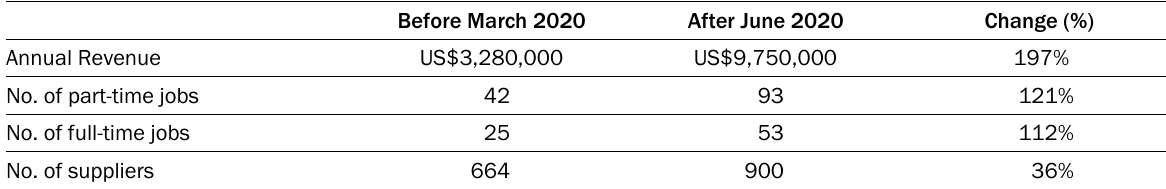
Table 2. Key Performance Indicators (KPI) of the 11 Food Hubs Surveyed that Represent their